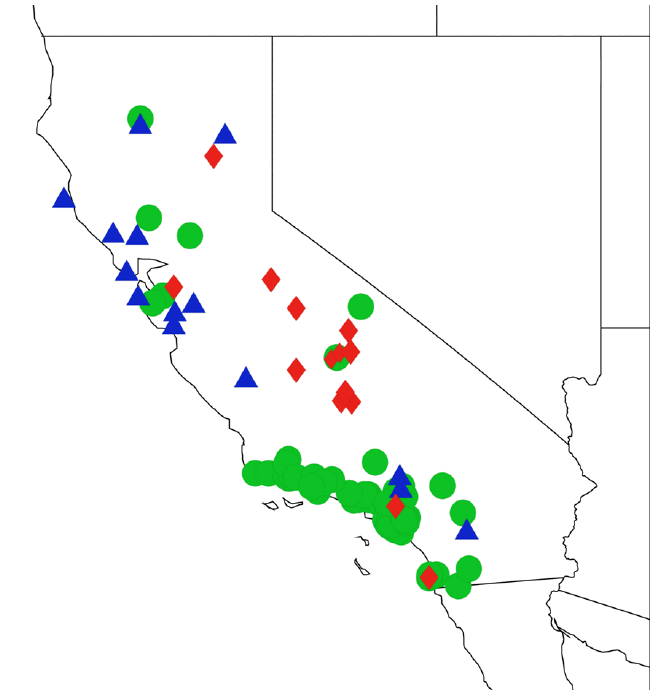
Figure 41. Distribution of Platypedia tomentosa (blue triangles), P. scotti (red diamonds), and P. vanduzeei (green squares).